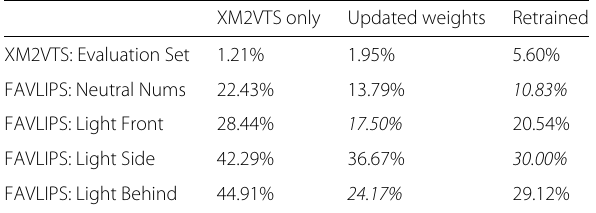
Table 8 Comparison of results from the 3 different LipAuth model weights presented in this section, against lighting conditions for the 20 unseen individuals from